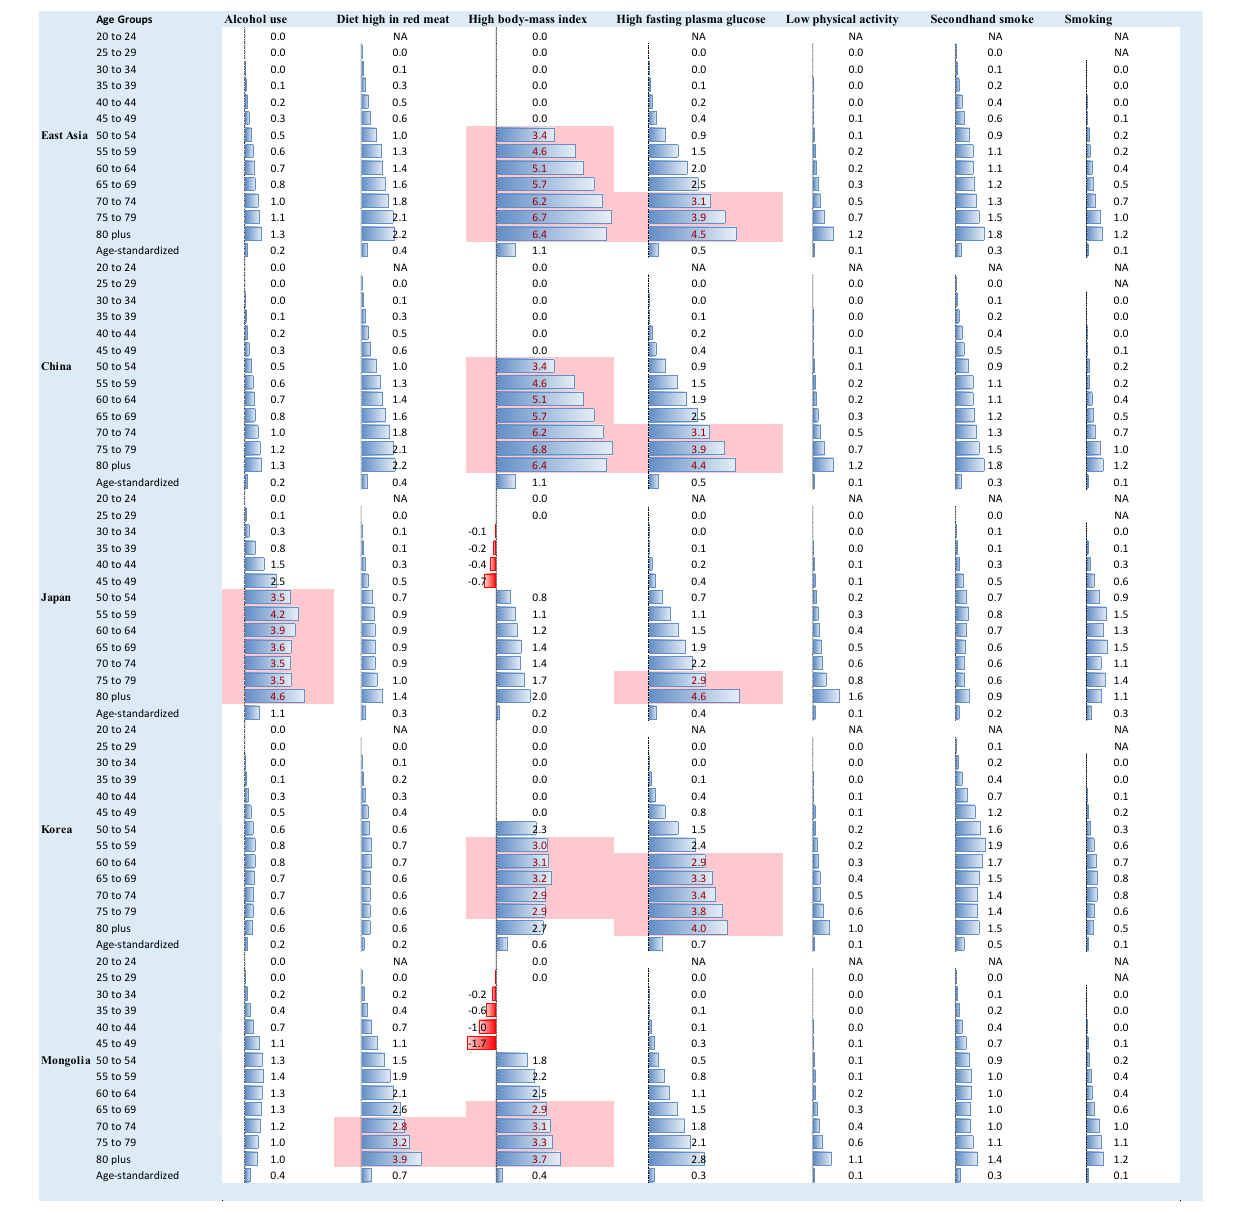
FIGURE 4 | Female deaths (rate per 100,000) due to BC in 2019 stratified by age group 20 to 80+ years, age-standardized rate, and by risk factors in East Asia, the value with pink background fall in the rank of top 10%, NA = data are not available for those age groups and risk